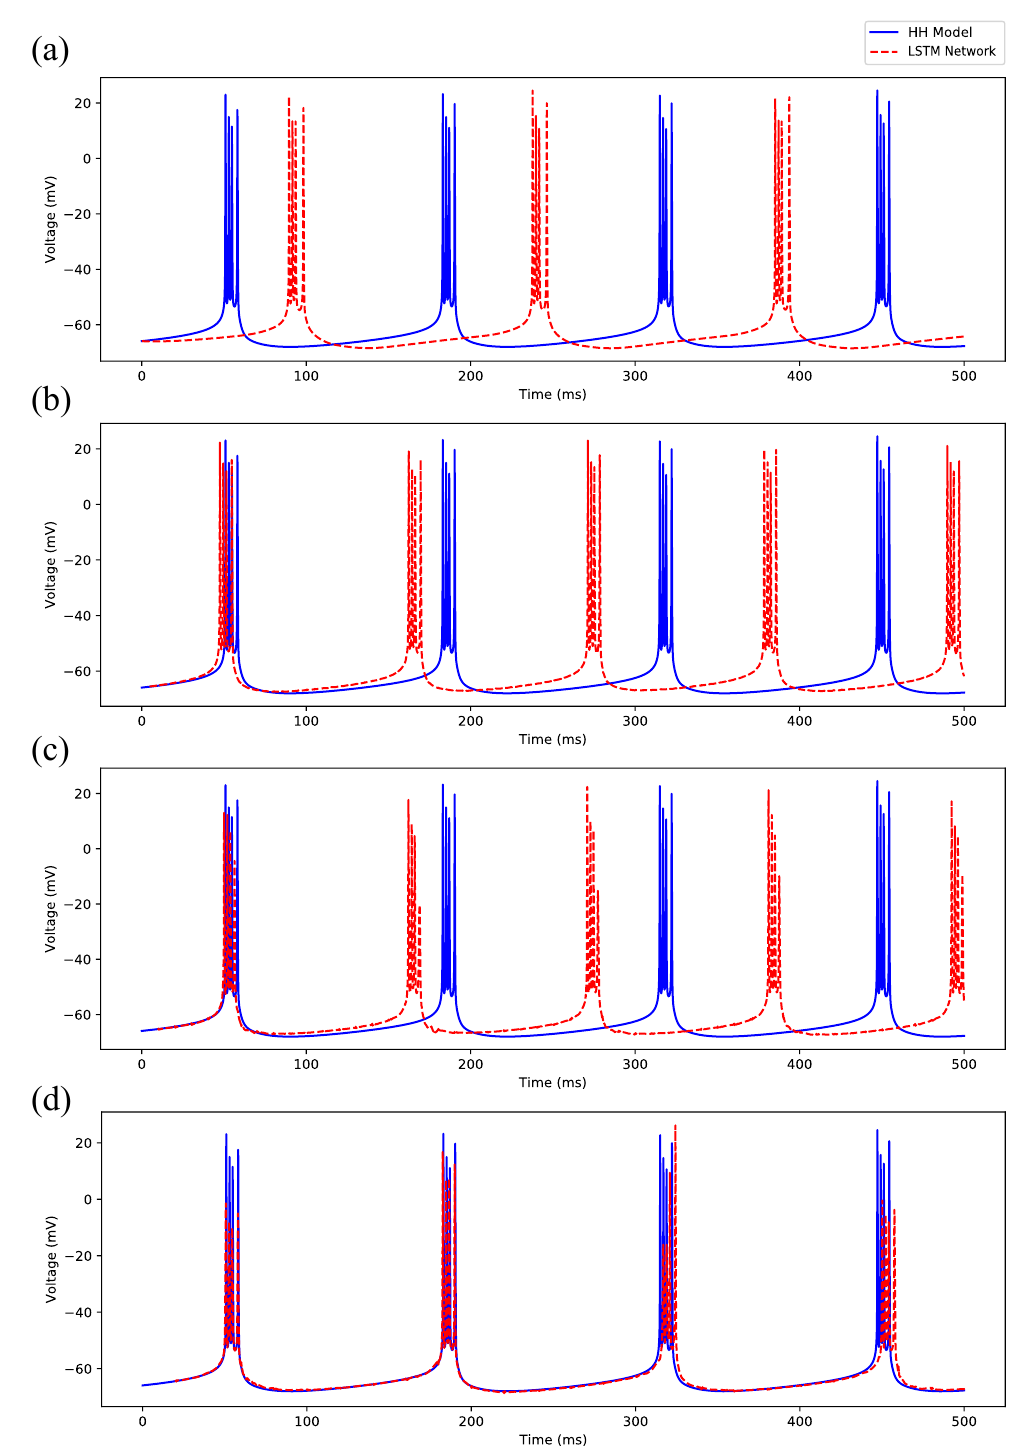
Figure 11. Comparison of predicted membrane potential traces by the LSTM network (“NN Prediction”) to the irregular bursting spiking patterns exhibited by the Hodgkin-Huxley model (“HH Model”) in response to the external stimulating current I = 0.5 nA. ( a ) Prediction using 1 timestep predictive LSTM network ( N p = 1); ( b ) Prediction using 50 timesteps predictive LSTM network ( N p = 50); ( c ) Prediction using 100 timesteps predictive LSTM network ( N p = 100); ( d ) Prediction using 200 timesteps predictive LSTM network ( N p =